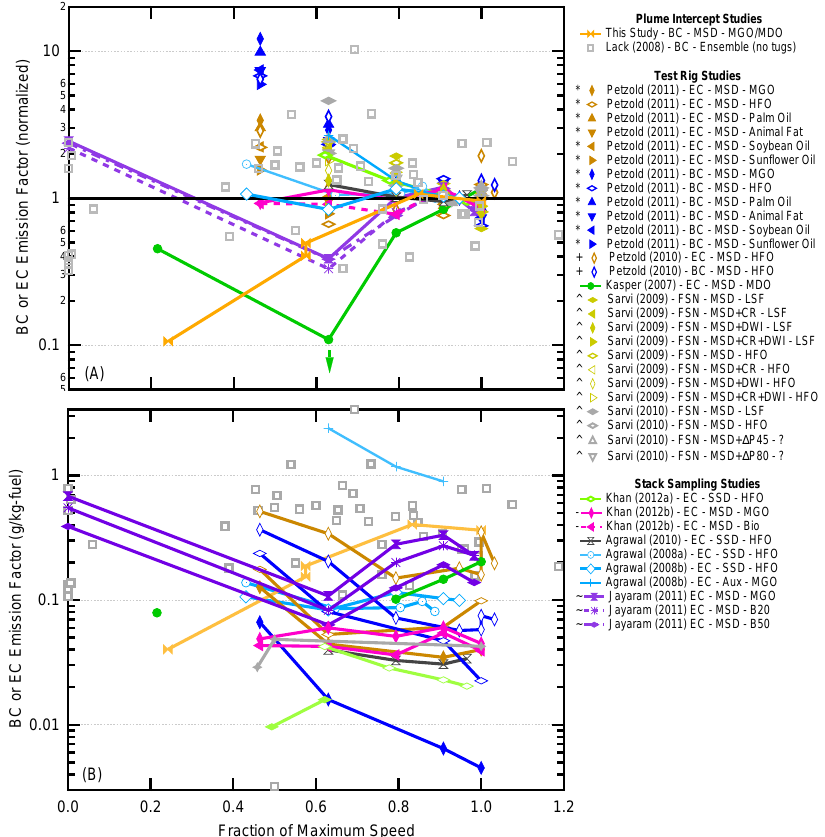
Fig. 5. Emissions factors (in g per kg fuel) for black carbon (BC), elemental carbon (EC) or the “filter smoke number” (FSN) as a function of the vessel speed ratio for multiple studies (A) normalized to a speed ratio of 95% (which corresponds to 85% load using the propeller law) load and (B) as absolute values. All BC emission factors correspond to equivalent BC, with the exception of the current study, which is the uncertainty weighted-average from the four measurement methods. The speed ratio is the ratio between the operating speed and the maximum ship speed, and for the test-rig and stack-sampling studies was estimated from the reported engine load using the propeller law. The legend groups the studies by measurement methodology: plume intercept, test-rig and stack sampling. The symbols in the legend indicate which studies were performed on the same engine or ship. The legend names indicate the study, measured parameter (BC, EC or FSN), engine type (MSD or SSD) and fuel type (HFO or low-sulfur, including biofuels, MDO and MGO). For the Sarvi studies, the additional information given after the engine type indicates a variation in the engine operation over the base case and includes use of a common rail injection system (CR), direct water injection (DWI), or variation in the fuel nozzle open pressure ( 1P ). The downward green arrow indicates that the actual EF reported for this point was actually